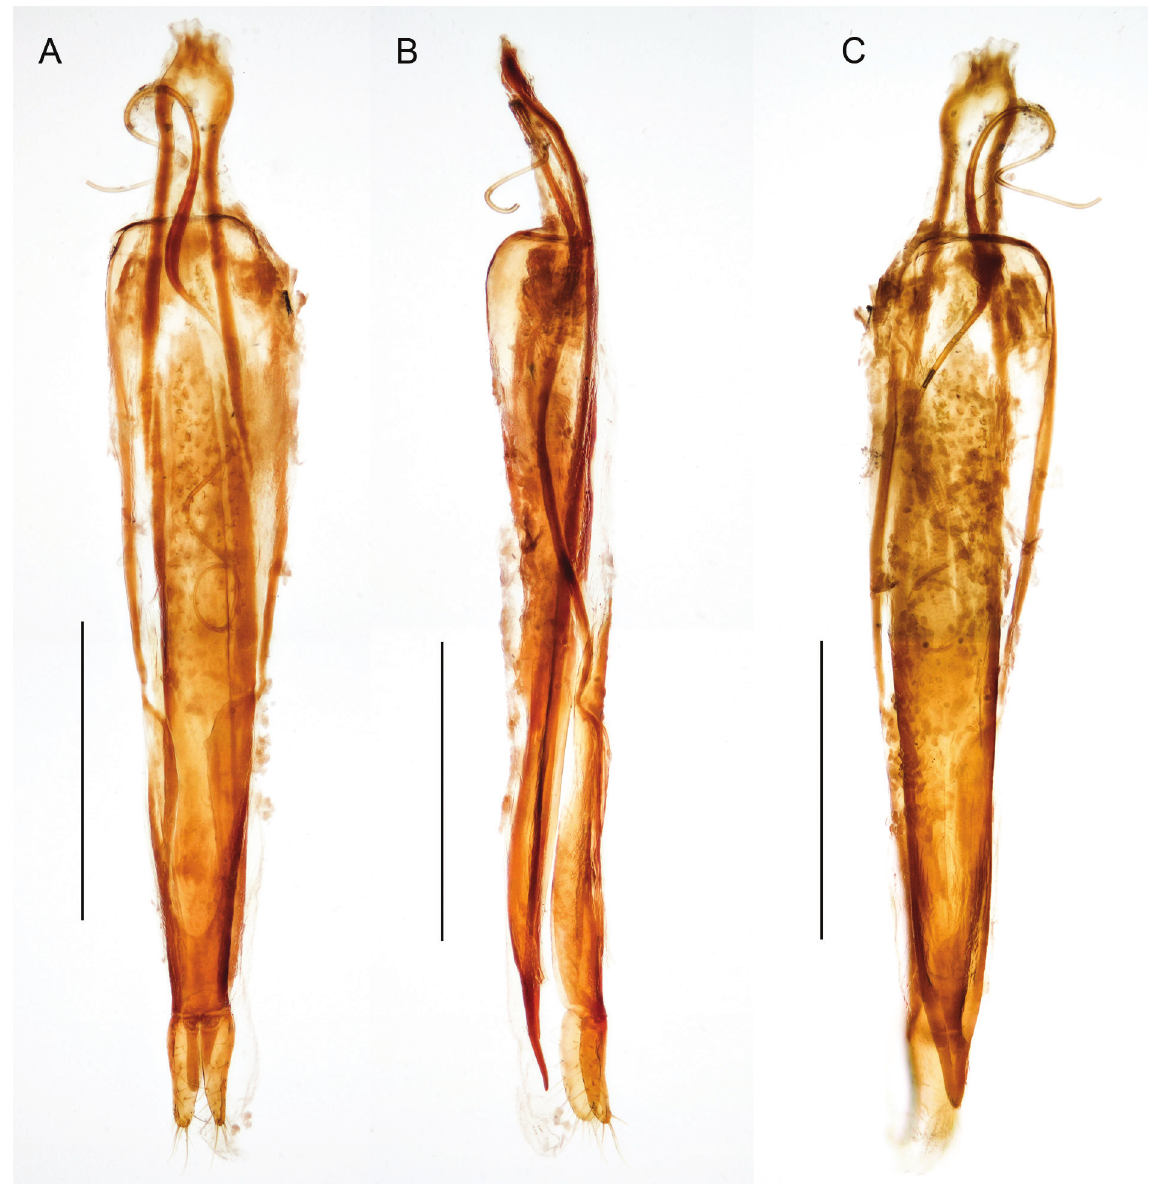
Fig. 13. Bolianus giannae gen. et sp. nov., holotype, aedeagus. A . ventral view. B . lateral view. C . Dorsal view. Scale bars = 0.5